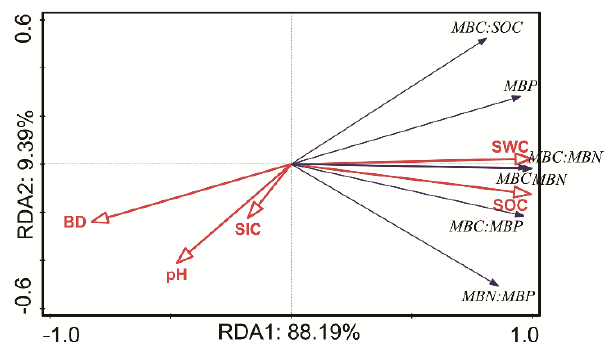
Figure 3. Ordination plots of the results from the redundancy analysis to identify the relationships between soil physiochemical properties (red arrows), soil microbial biomass, microbial biomass C:N:P stoichiometry, and microbial quotient (blue arrows) ( n = 3). The STC was highly correlated with SOC (Pearson R = 0.955), thus it was removed from this analysis (Table S2).